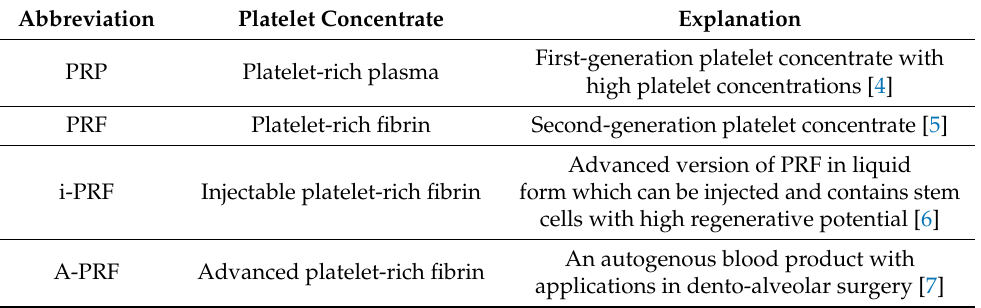
Table 1. Abbreviation of different platelet concentrates.